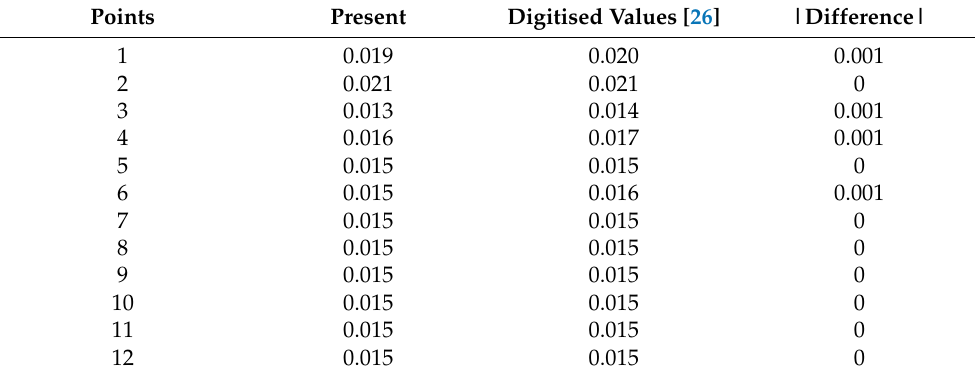
Table 3. The amplitude (mm) of the points represented on Figure 5a. Points Present